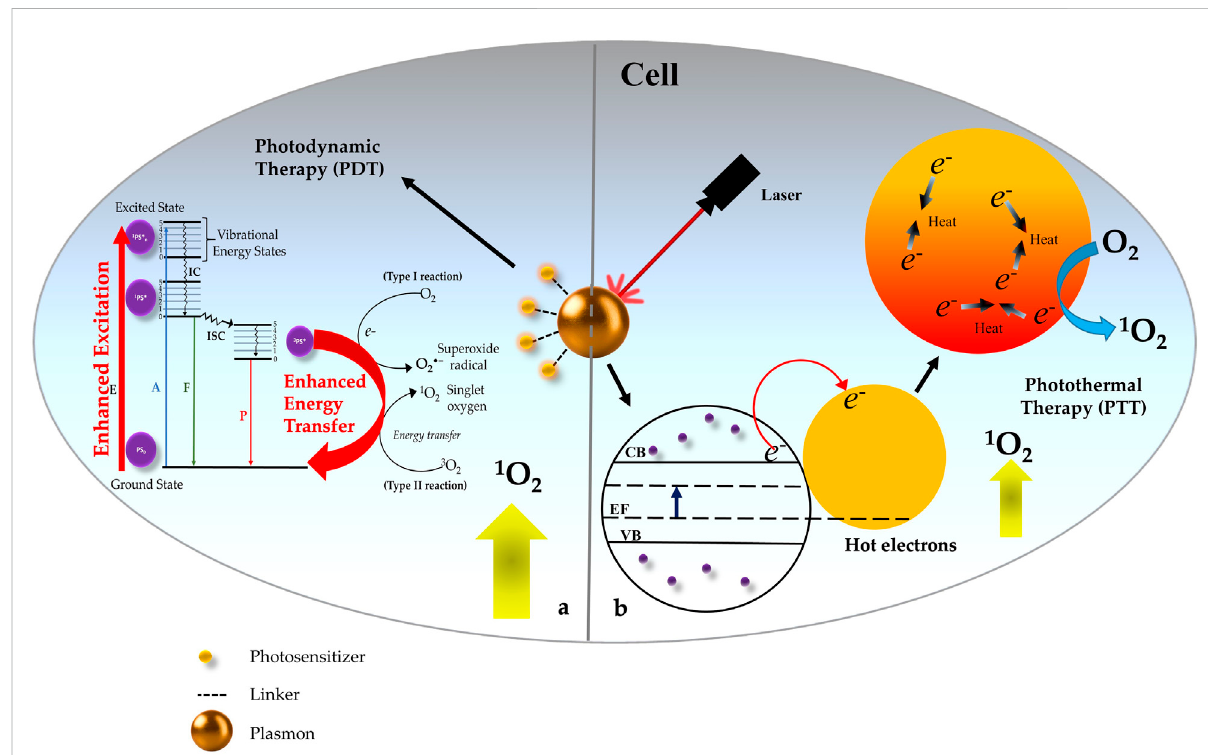
FIGURE 5 Schematic representation of Photothermal Therapy (PTT) and Photodynamic Therapy (PDT) effects of metal plasmonic nanoparticles (NP) withinthecell. (A) ExcitationofNP incombination withPhotosensitizer (PS) causes photosensitizedsingletoxygen ( 1 O 2 )productionthroughsurface plasmon-photosensitizer (PS) resonance coupling which occurs due to enhanced excitation in the conjugates with good spectral overlap between thesurfaceplasmon ofNPsand theabsorptionofthePS. (B) ExcitationofNPwithout PSmajorly resultsinto PTTdueto localheatingeffectand moderate level of ( 1 O 2 ) generation due to Hot electron transfer within the plasmonic NP